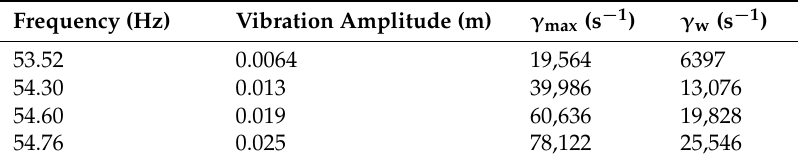
Table 4. Average and maximum shear rate of the studied VSEP system.